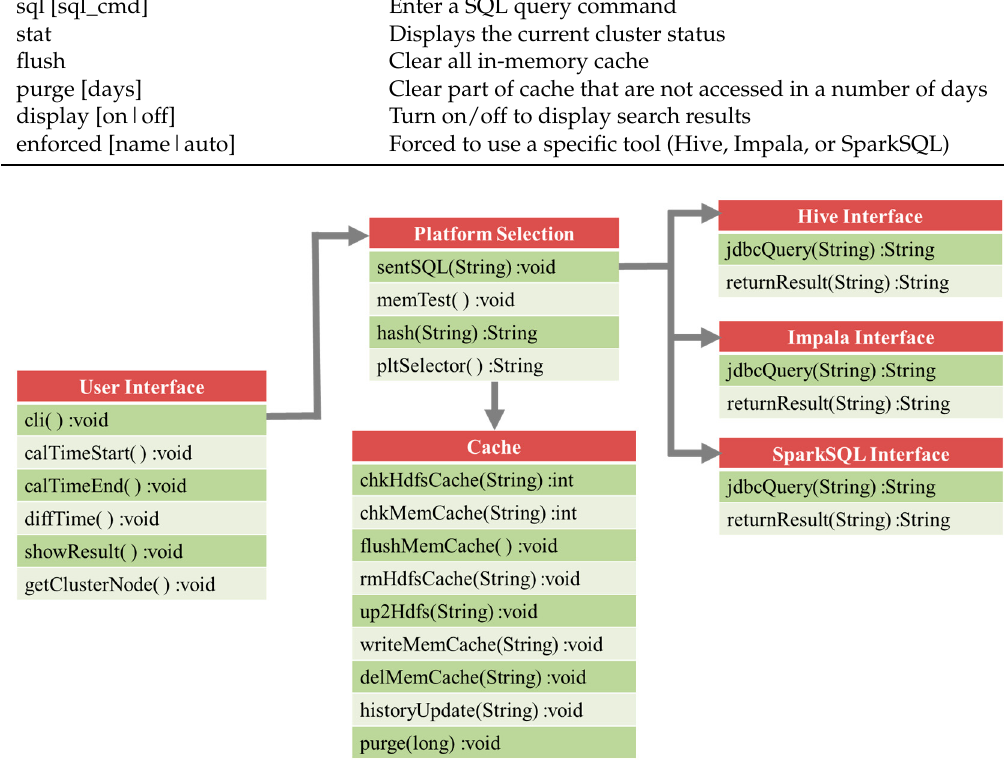
Figure 14. UML diagram of the code architecture.